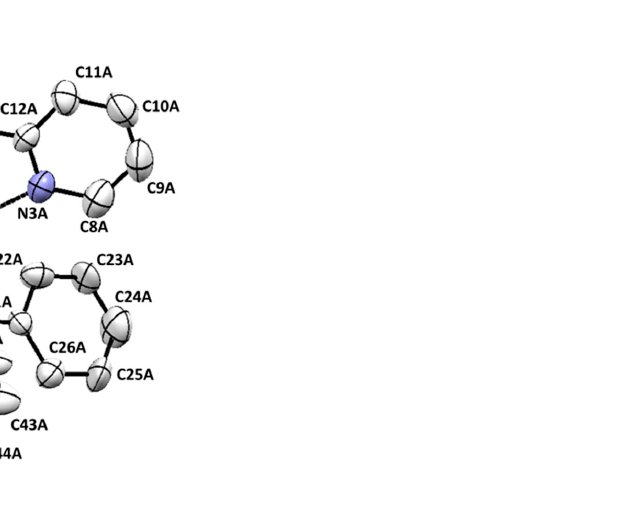
Figure 2. ORTEP representation of one of the molecules presents in the crystal structure of compound 1 (hydrogen atoms have been omitted for clarity). Table 1. Selected bond lengths (Å) and angles ( ◦ ) for 1